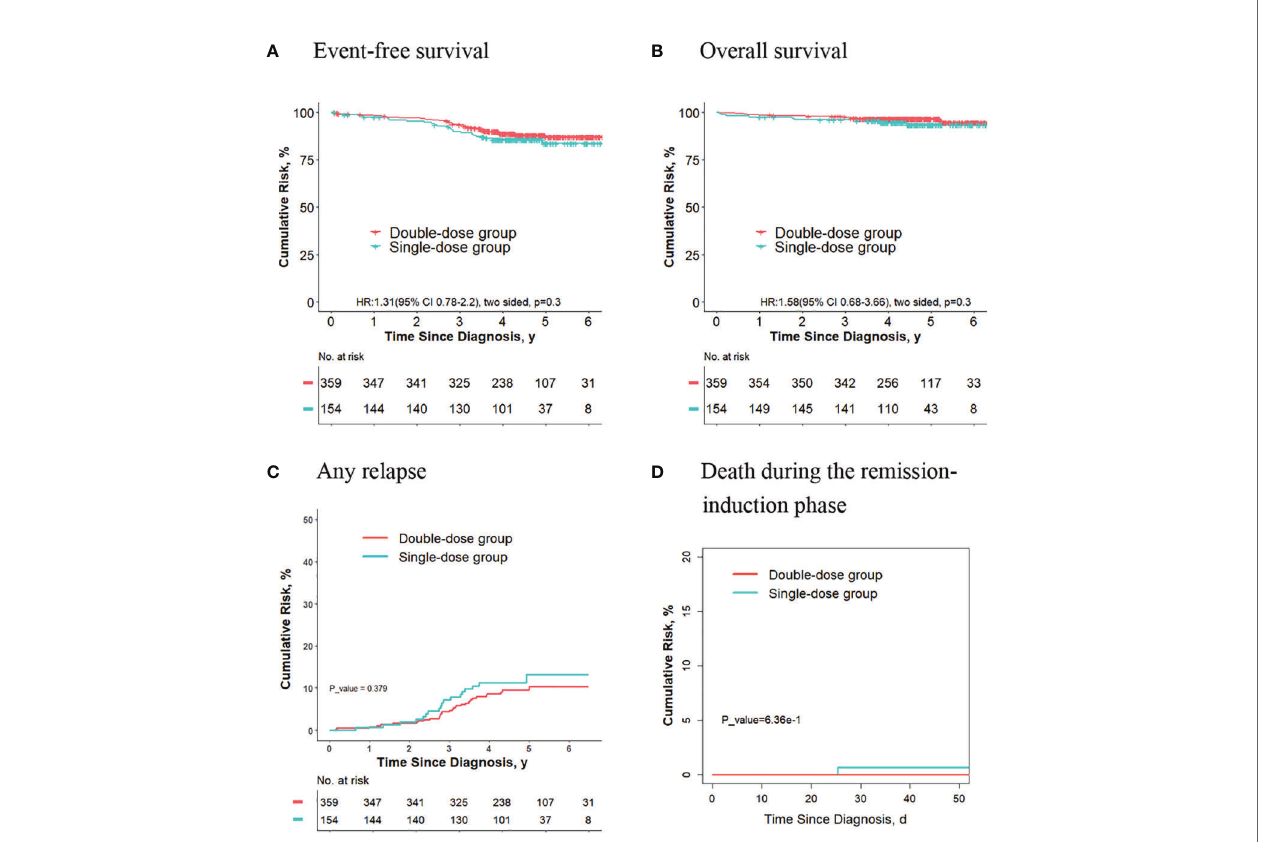
FIGURE 5 | Analysis of survival and cumulative risk of relapse and early death for fi nal low-risk patients with hyperdiploidy